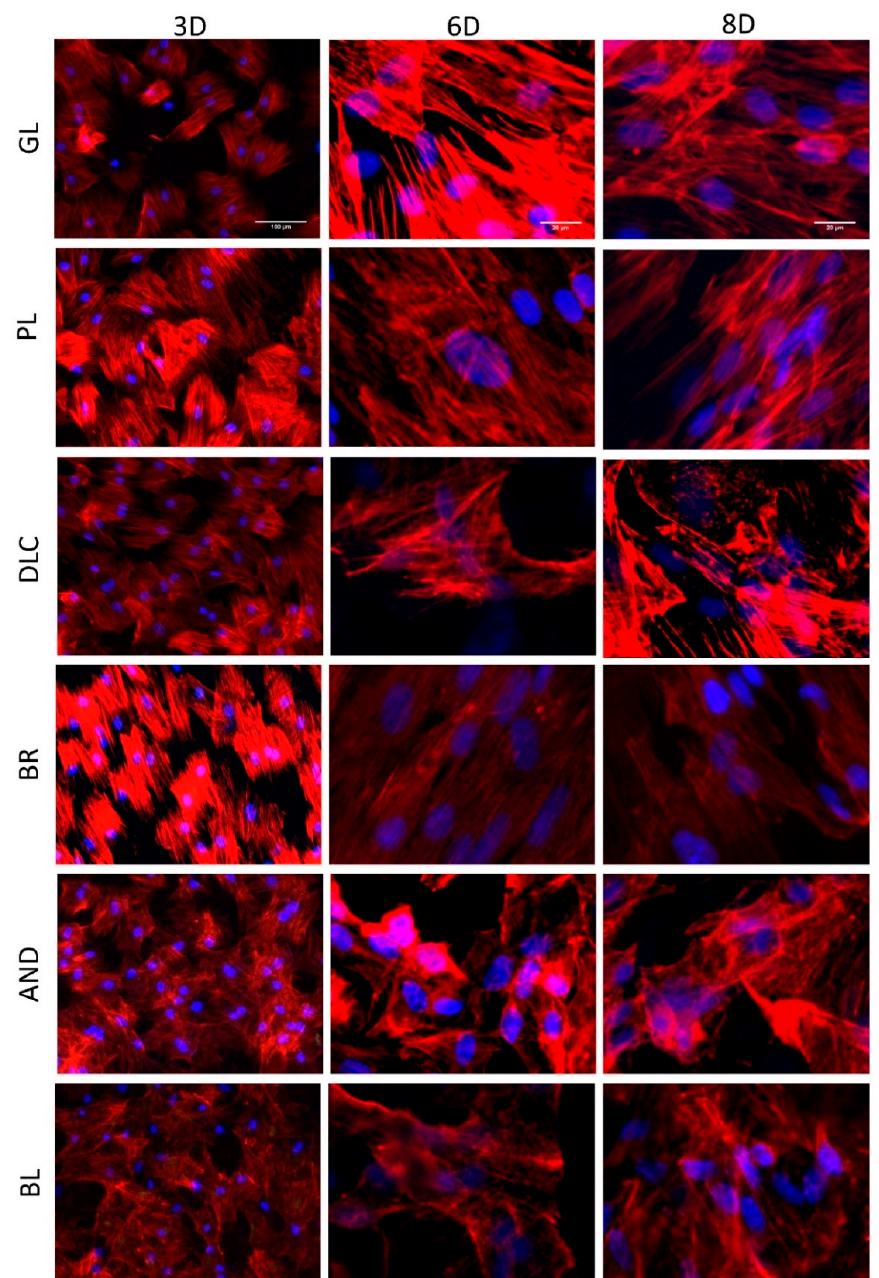
Figure 6. A comparison of the morphology of the cells on the reference glass coverslips (GL) and on the Ti6Al4V samples modified by polishing (PL), by DLC-coating (DLC), by brushing (BR), by anodizing (AND), or by blasting (BL) after 3, 6, and 8 days of cultivation. (3D, 6D, and 8D, respectively). Leica DMi8 microscope. 3D: overall picture of the cell culture, objective 10x, scale bar 100 µ m; 6D, 8D: cells in detail, objective 40x, scale bar 20 µ